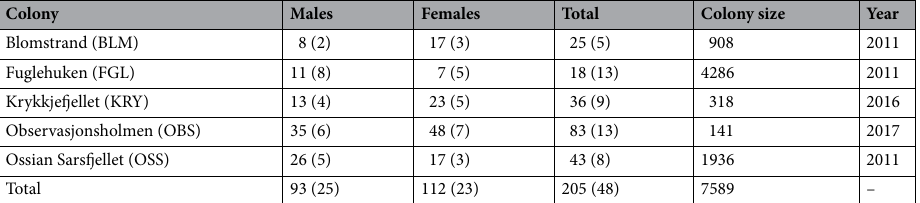
Table 1. Number of black-legged kittiwake foraging trips recorded during the chick-rearing period in 2017 in five colonies located in the Kongsfjorden region, Svalbard. The number of individuals tracked in each colony is indicated in parentheses. The size (number of breeding pairs) of each colony and the year of the colony survey are also